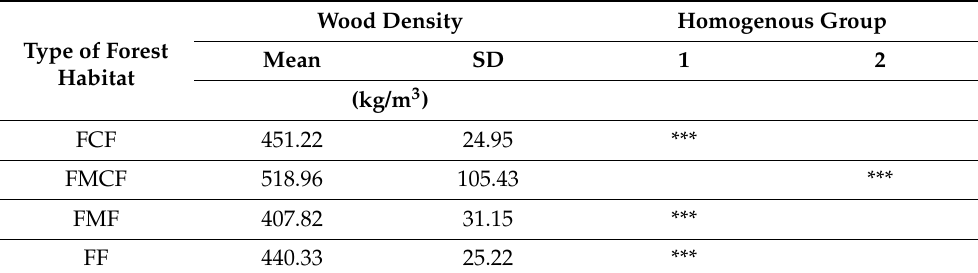
Table 1. Statistically homogeneous groups based on the Tukey HSD test for the wood density in the forest habitats at a 95% confidence interval.